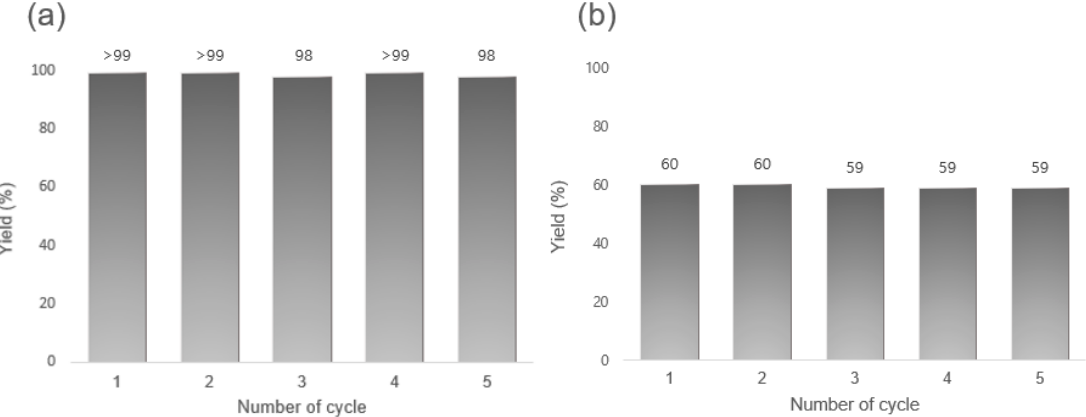
Figure 5. Recycle ability test of selective oxidation for ( a ) benzylalcohol and ( b ) 5-hydroxymethylfurfural (HMF).